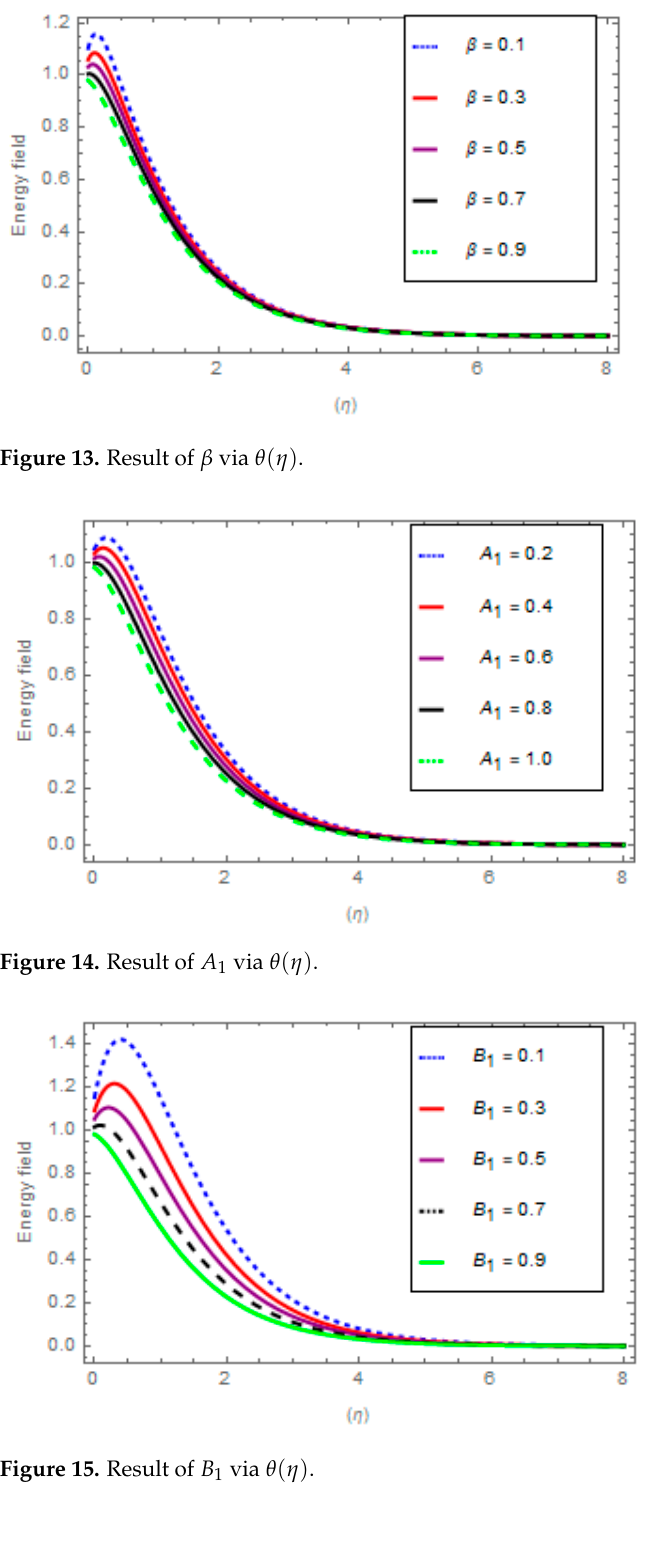
Figure 15. Result of B 1 via θ ( η )